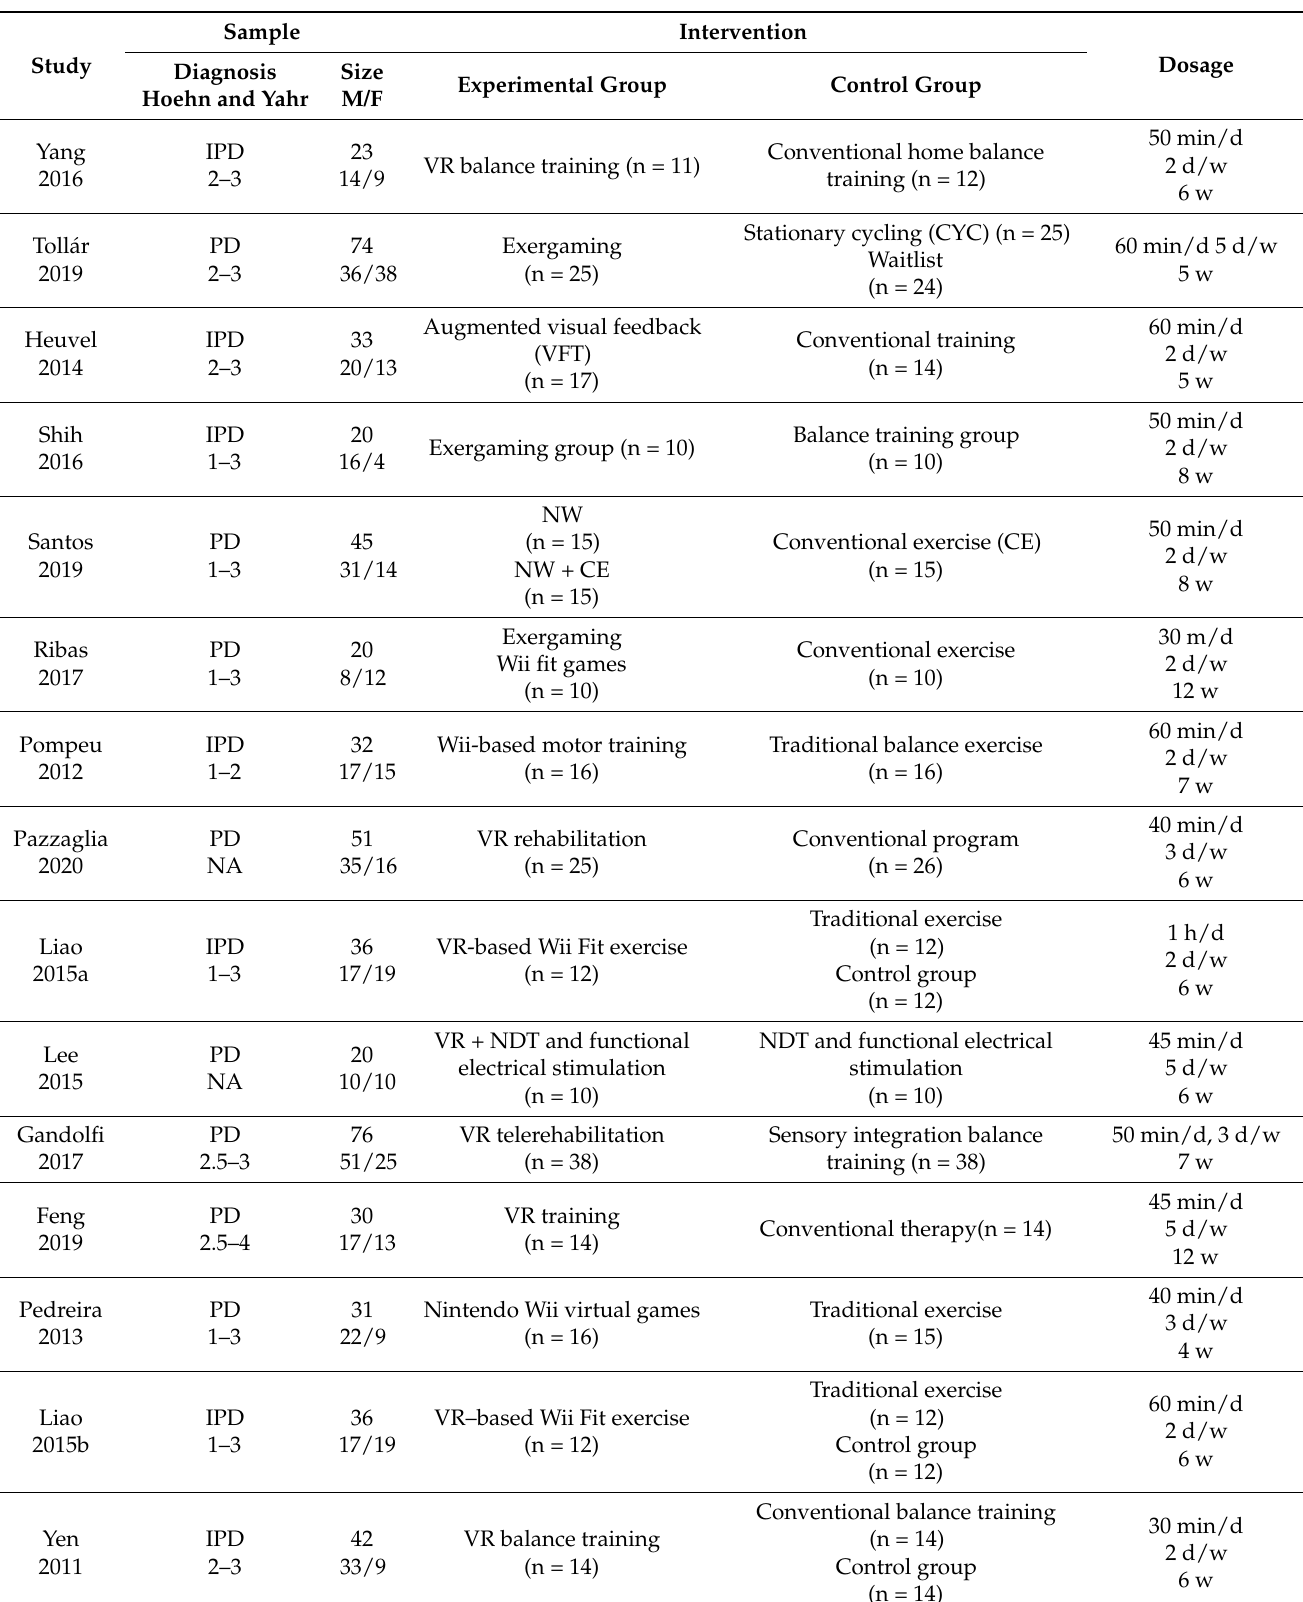
Table 2. Characteristics of the included